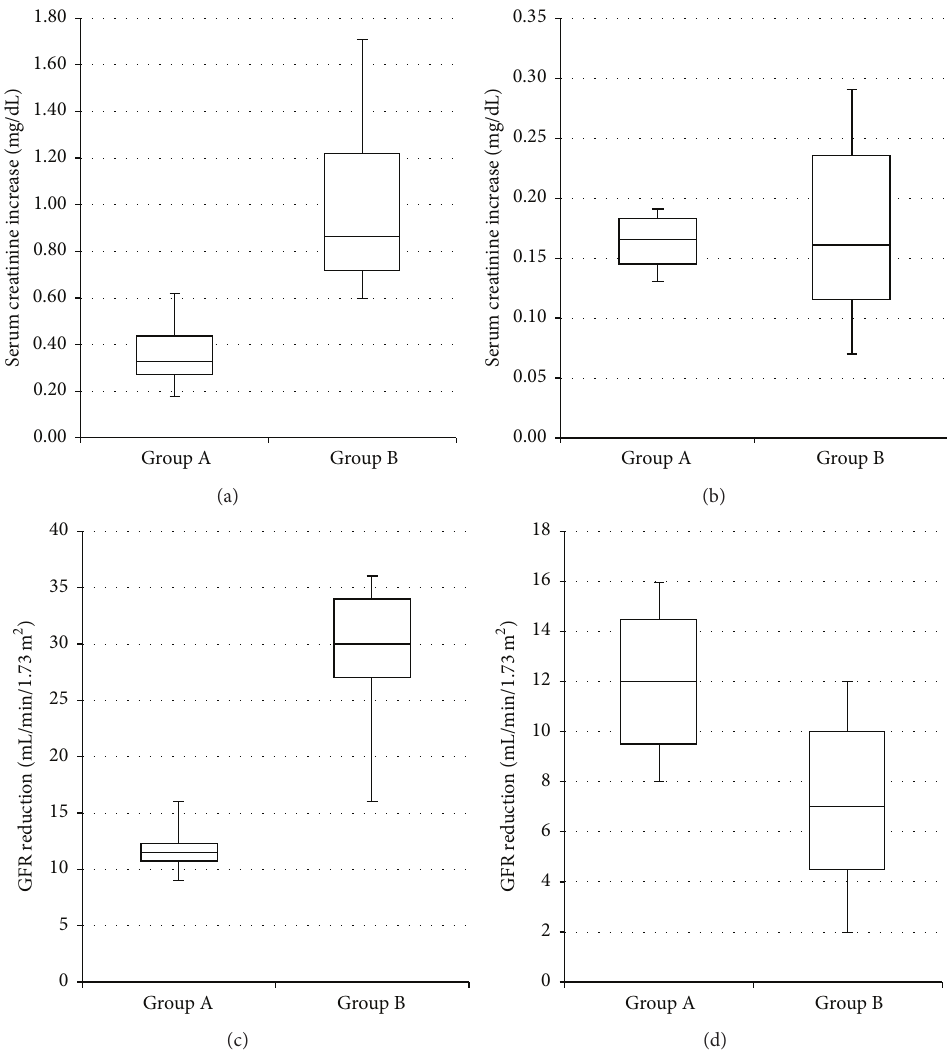
Figure 1: ((a) and (b)) Comparison of the increase in serum creatinine between Group A and Group B patients (Mann-Whitney for independent samples). ((c) and (d)) Comparison of the decrease in eGFR between Group A and Group B patients (Mann-Whitney for independent